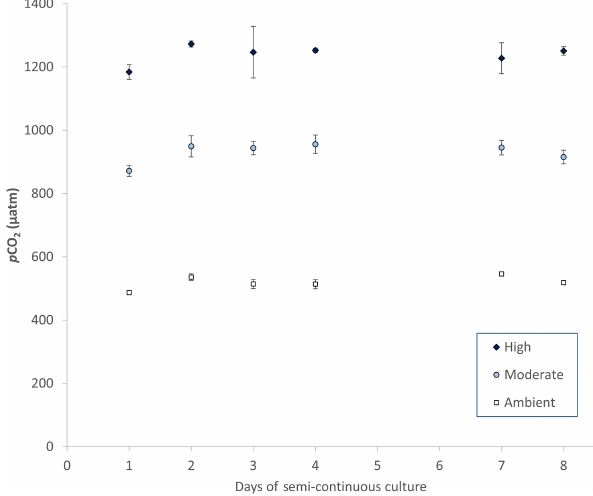
Figure 3. Maintenance of p CO 2 over time in mixed cultures of the copepod Calanus pacificus and its prey Ditylum brightwellii ( n = 3, Experiment 2). Cultures were maintained in atmospheric chambers under semi-continuous culture with artificial atmospheres with no bubbling and media for daily dilutions was bubbled with air at 400 (ambient), 800 (moderate), and 1200 (high) µatm p CO 2 . Val- ues are means; error bars are standard deviation.